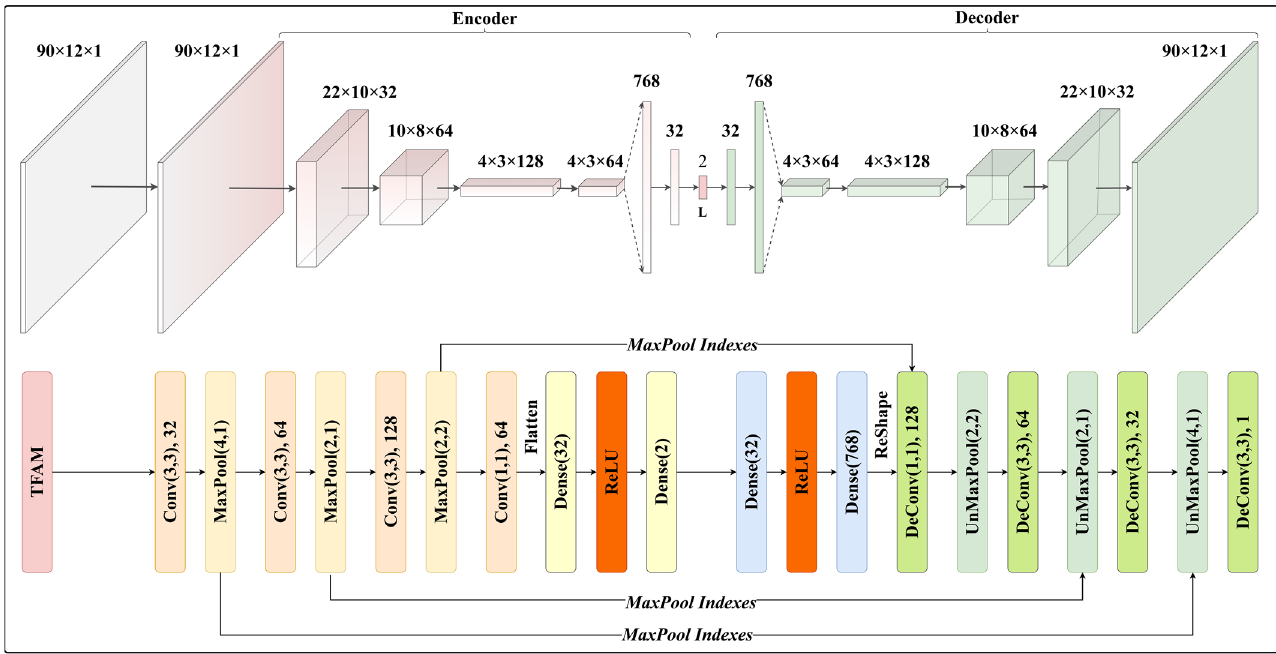
Figure 7. Structure and parameters of TFA-CAE.